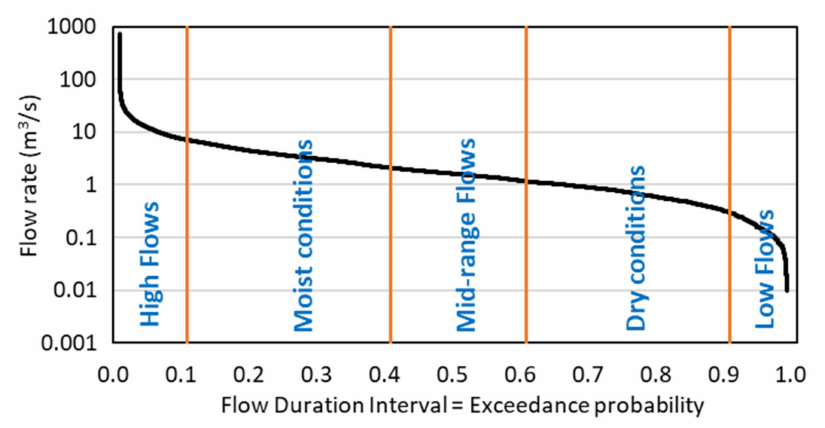
Figure 5. General form of the EPA intervals for the flow duration curve (adapted from [41]). The method implemented in our study used self-adaptative log-equidistant flow intervals specific to each river. These intervals are self-adaptative because only sampled flows are taken into account for their determination. The intervals are determined on the basis of the log-values of the flows and not on their observation probability. Interval lengths are defined so that log(Q sup) − log(Q inf) = constant. Figure 6 illustrates the intervals thus defined. The five intervals on the left have the same “thickness” on the log-scale graph of flows. Due to the presence of zero flow values (leading to an inability to calculate the log values), the low-flow interval is set to the ninetieth percentile of the flow duration curve (i.e., the last decile), as in the EPA method.